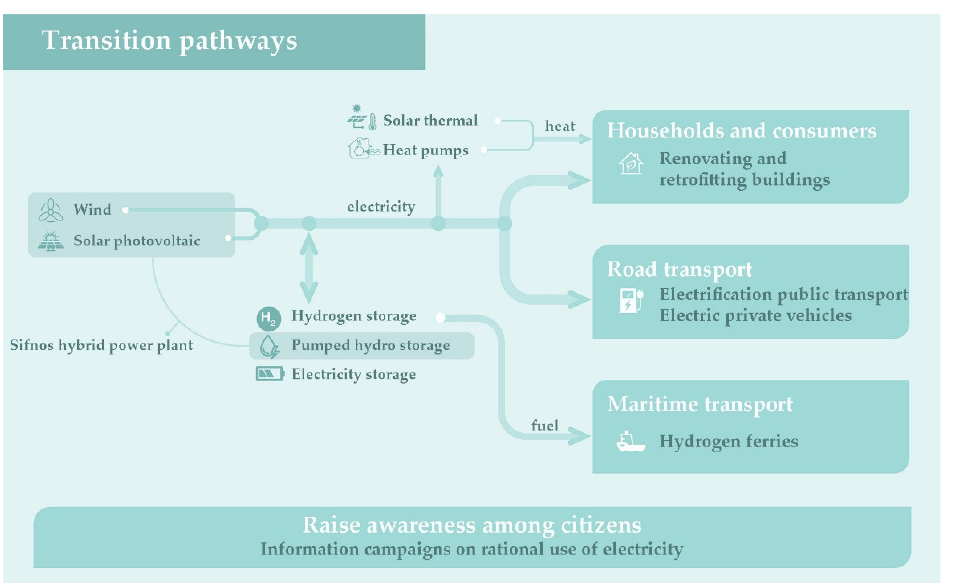
Figure 8. Visual summary of the Clean Energy Transition Agenda of Sifnos [77].